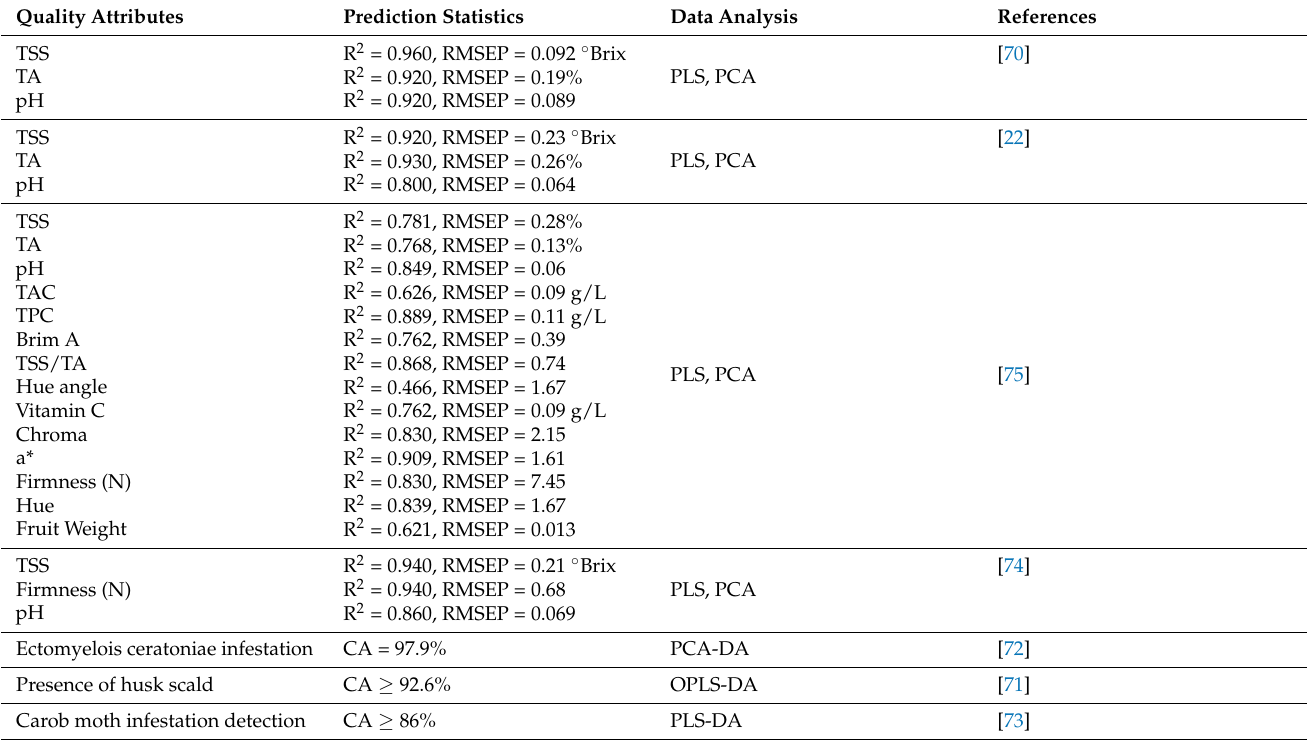
Table 2. Summary of application of Vis/NIR spectroscopy for intact pomegranate quality